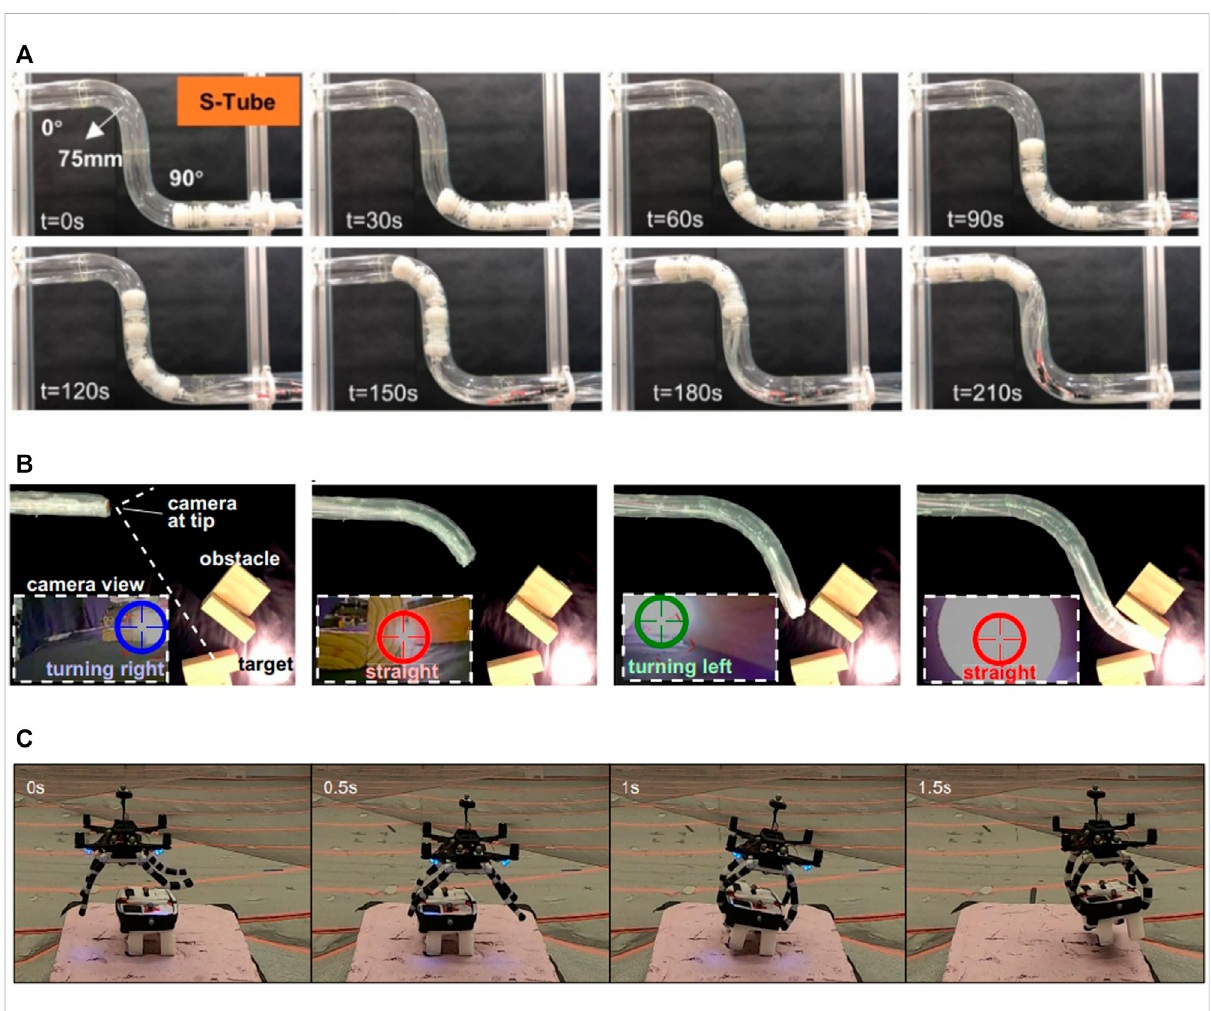
Examplesofsoftroboticsystemsperformingtasksusefulforinfrastructureprotection. (A) SoftcrawlernavigatinganS-shapedpipe[Figureadapted from Liu et al. (2022), (CC BY 4.0)]. (B) Inspection skills of a vine robot [Figure adapted from Hawkes et al. (2017), © [2017] AAAS. Reprinted with permission]. (C) Aerial dynamic grasping using a soft gripper [Figure adapted from Fishman et al. (2021), © [2021] IEEE. Reprinted with